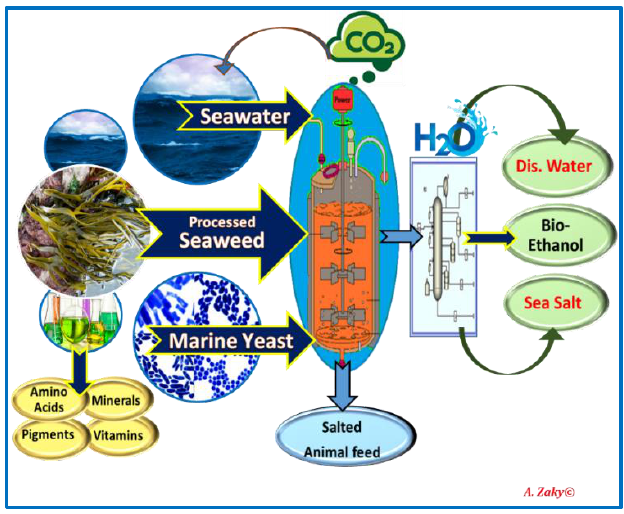
Figure 3. CMB system for the production of bioethanol (Route 1).